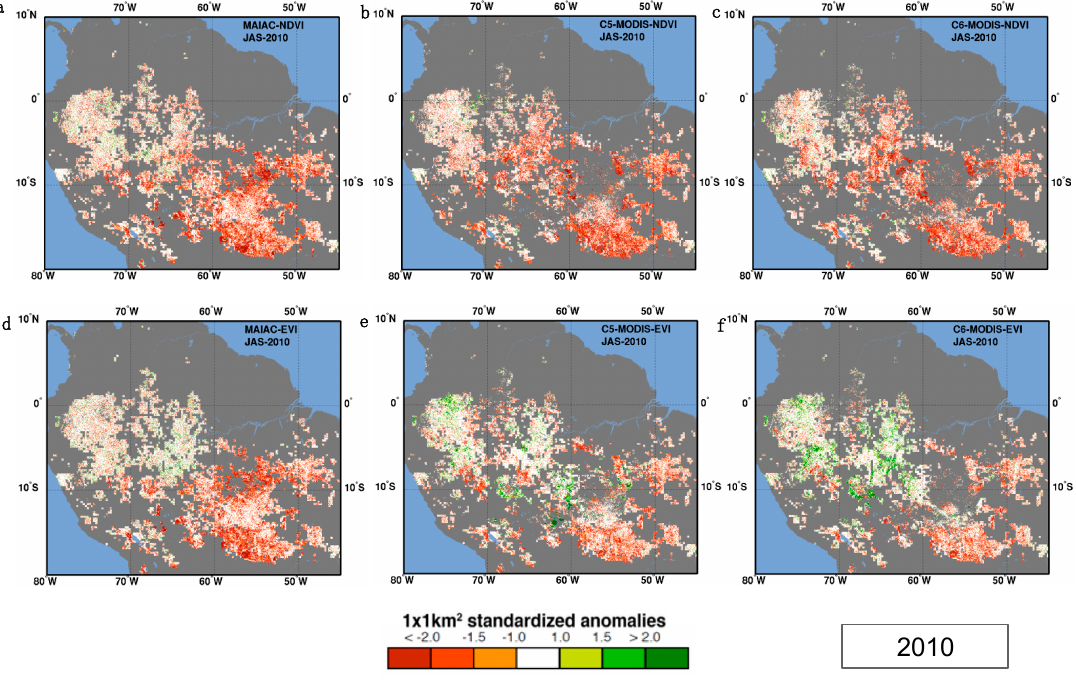
Figure 4. Spatial patterns of remotely sensed Amazonian dry season greenness standardized anomalies of the drought-affected vegetation, including forests, over Amazon in the 2010 drought year. The Amazonian dry season generally lasts from July to September (JAS). ( a ) Results from MAIAC NDVI data; ( b ) Results from Collection 5 MODIS NDVI data; ( c ) Results from Collection 6 MODIS NDVI data; ( d ) Results from MAIAC EVI data; ( e ) Results from Collection 5 MODIS EVI data; ( f ) Results from Collection 6 MODIS EVI data.